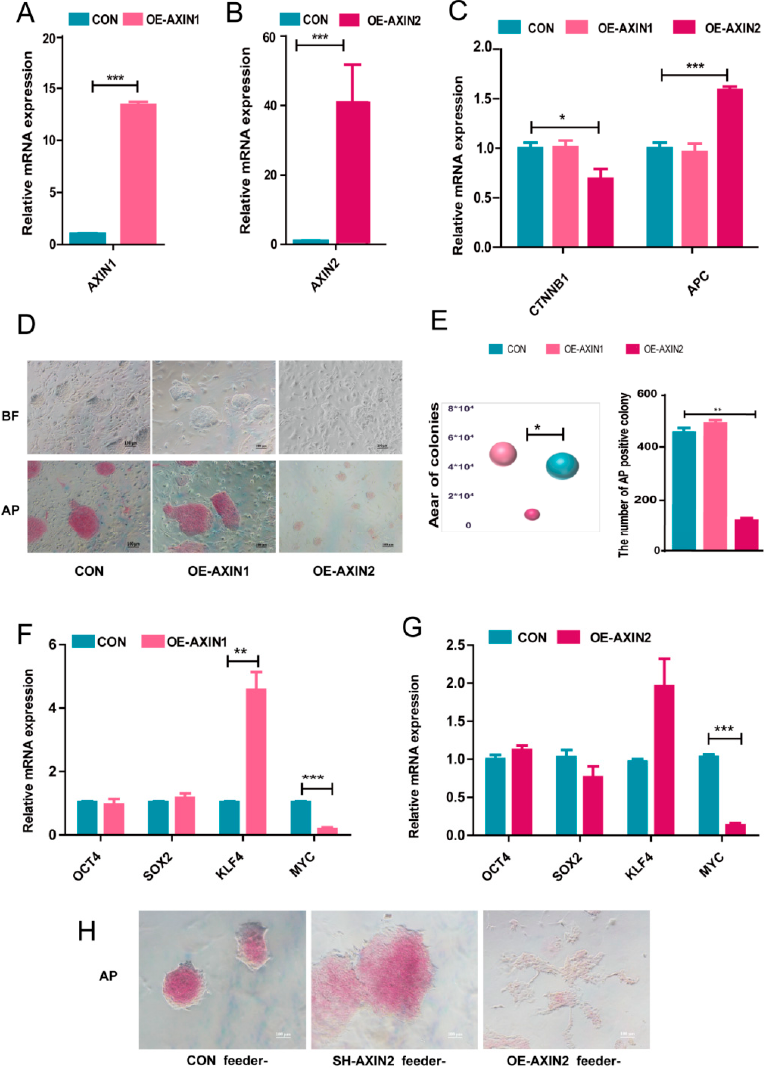
Figure 3. Overexpression of AXIN1 and AXIN2 in piPSCs. ( A ) qPCR analysis of the expression levels of AXIN1 in the control (CON) and overexpressing AXIN1 (OE-AXIN1) groups; ( B ) qPCR analysis of AXIN2 in the control (CON) and overexpressing AXIN2 (OE-AXIN2) groups; ( C ) qPCR analysis of and APC in the CON, OE-AXIN1, and OE-AXIN2 groups; ( D ) representative image of bright and AP positive colonies after 5 days of clonal growth in the CON, OE-AXIN1, and OE-AXIN2 groups; the scale bar represents 100 μ m; ( E ) the area of CON, OE-AXIN1, and OE-AXIN2 colonies; the quantities of AP positive colonies in the CON, OE-AXIN1, and OE-AXIN2 groups; ( F ) qPCR analysis of endogenous OCT4 , SOX2 , K LF4 , and MYC in NC and OE-AXIN1; ( G ) qPCR analysis of endogenous OCT4 , SOX2 , K LF4 , and MYC in the CON and OE-AXIN2 groups; ( H ) representative image of AP staining after 5 days of clonal growth without feeder in the CON, sh-AXIN2, and OE- AXIN2 groups; the scale bar represents 100 μ m. * represents p < 0.05, ** represents p < 0.001, *** represents p < 0.0001.